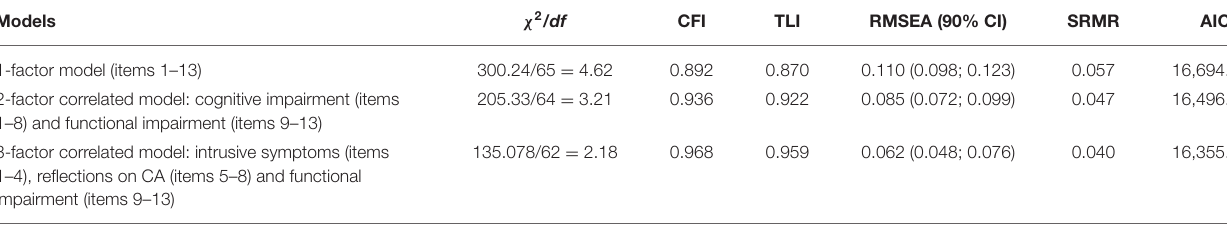
TABLE 3 | Goodness-of-fit indices for the CAS models (robust ML estimation).